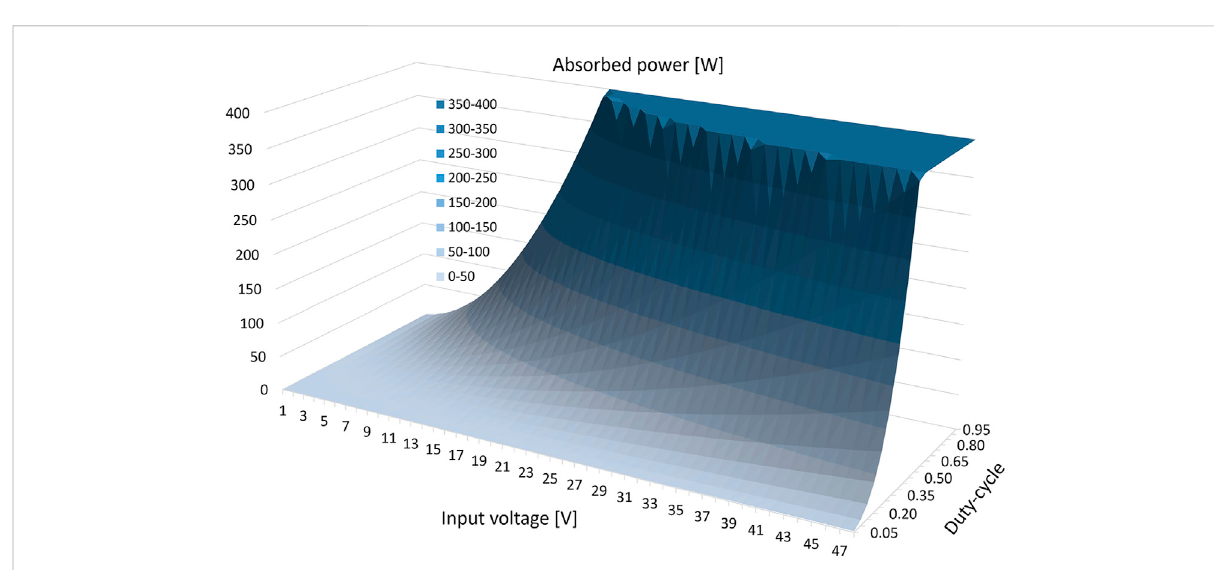
FIGURE 5 Surface plot of the total input absorbed power versus the input voltage and the duty-cycle.